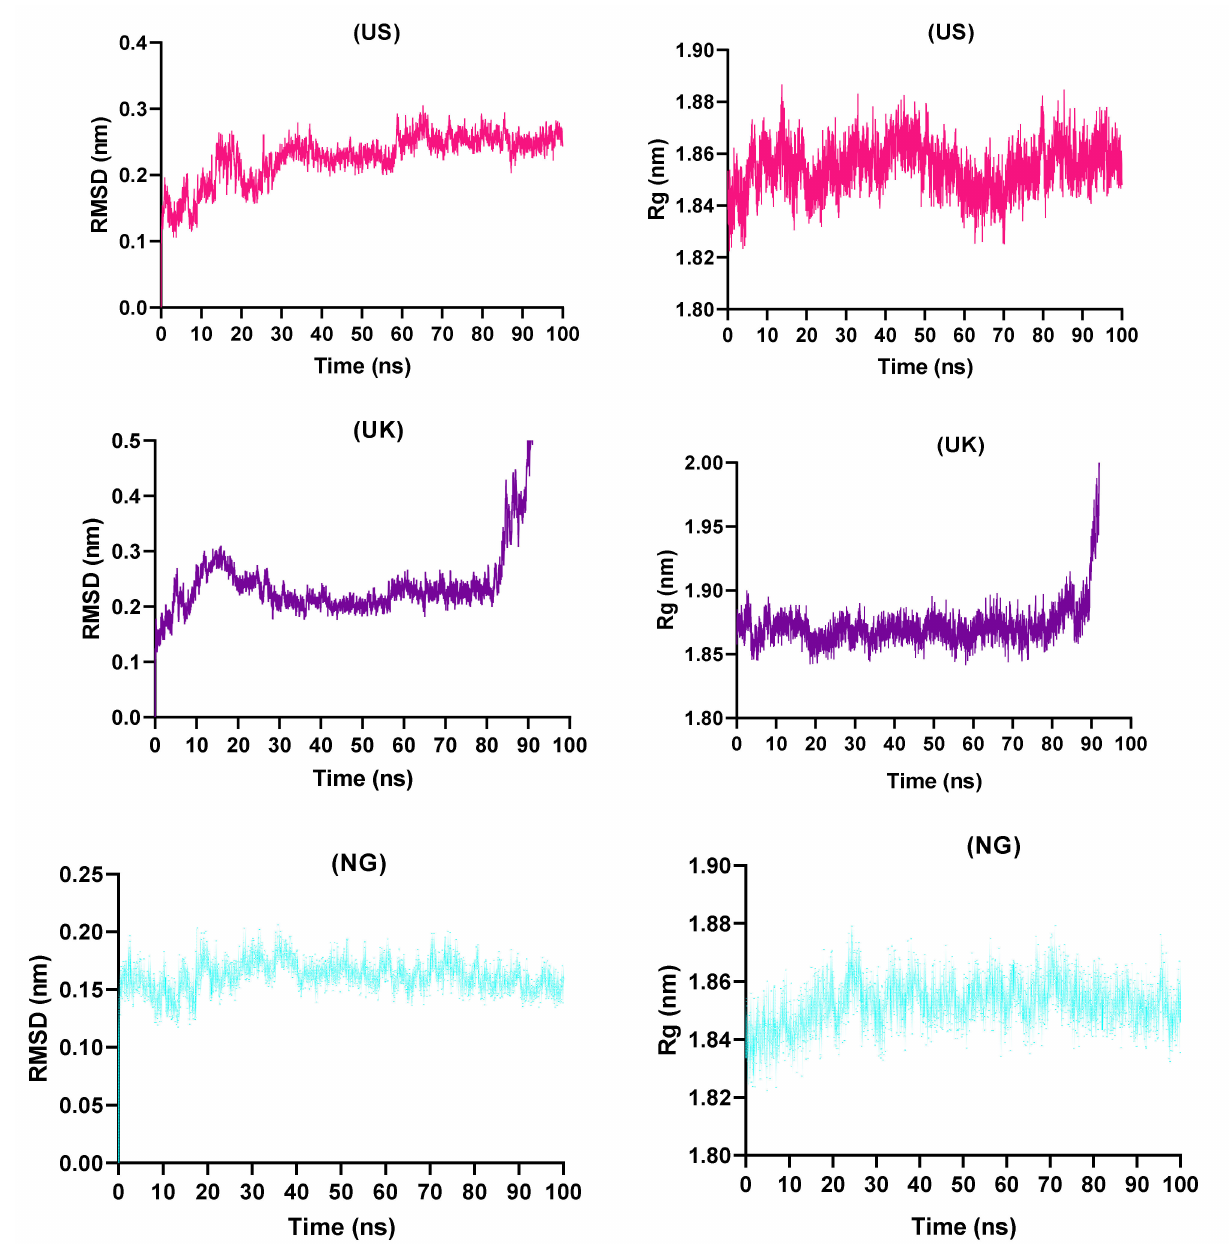
Figure 6. The root-mean-square deviation (RMSD) and radius of gyration (Rg) values obtained during molecular dynamics simulations of bromelain peptide with the RBD wild type (WT) and BR, US, UK, and NG